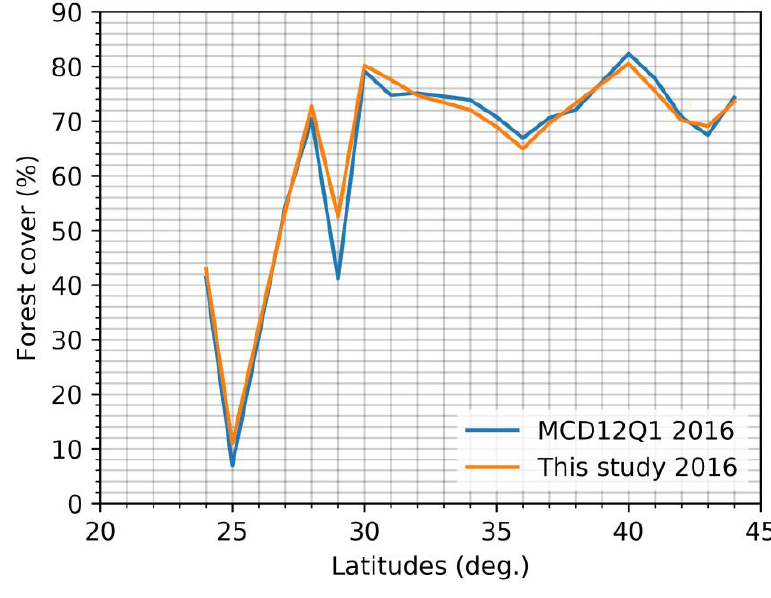
Figure 3. Variation of the percentage forest cover with respect to latitude estimated by two different maps (MCD12Q1 and our map).